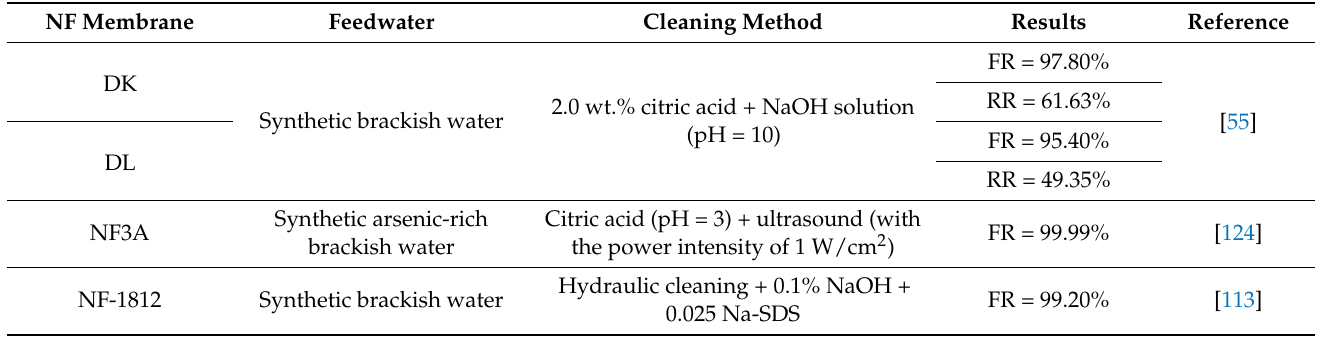
Table 3. Typical membrane cleaning examples related to the treatment of brackish water.